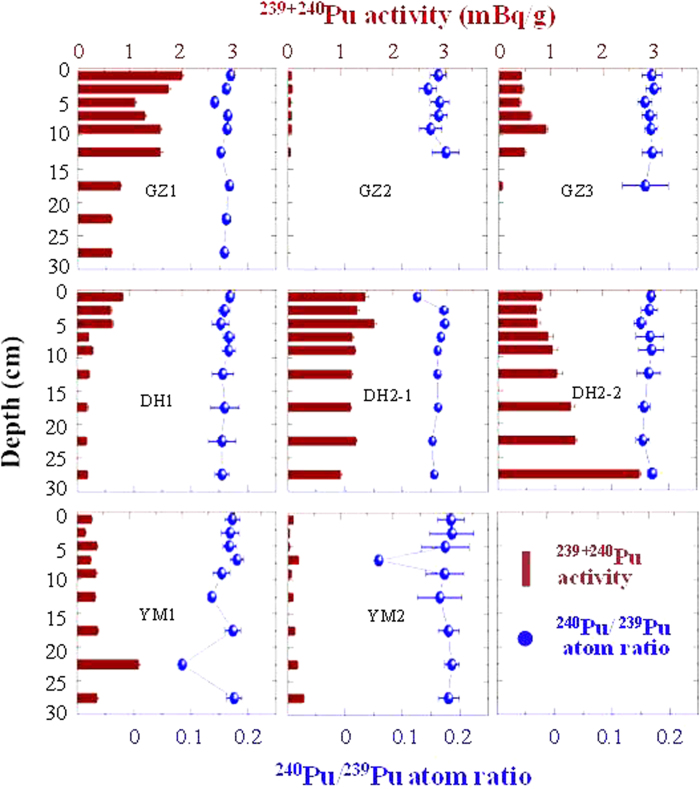
Vertical distributions of 239+240Pu activities and 240Pu/239Pu atom ratios in the soil cores.